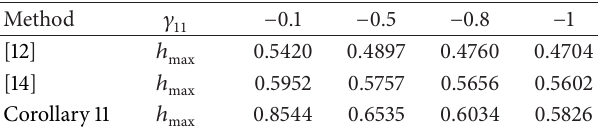
Table 5: The maximum allowable upper bound for different 𝛾 with = 0 ℎ 𝑑